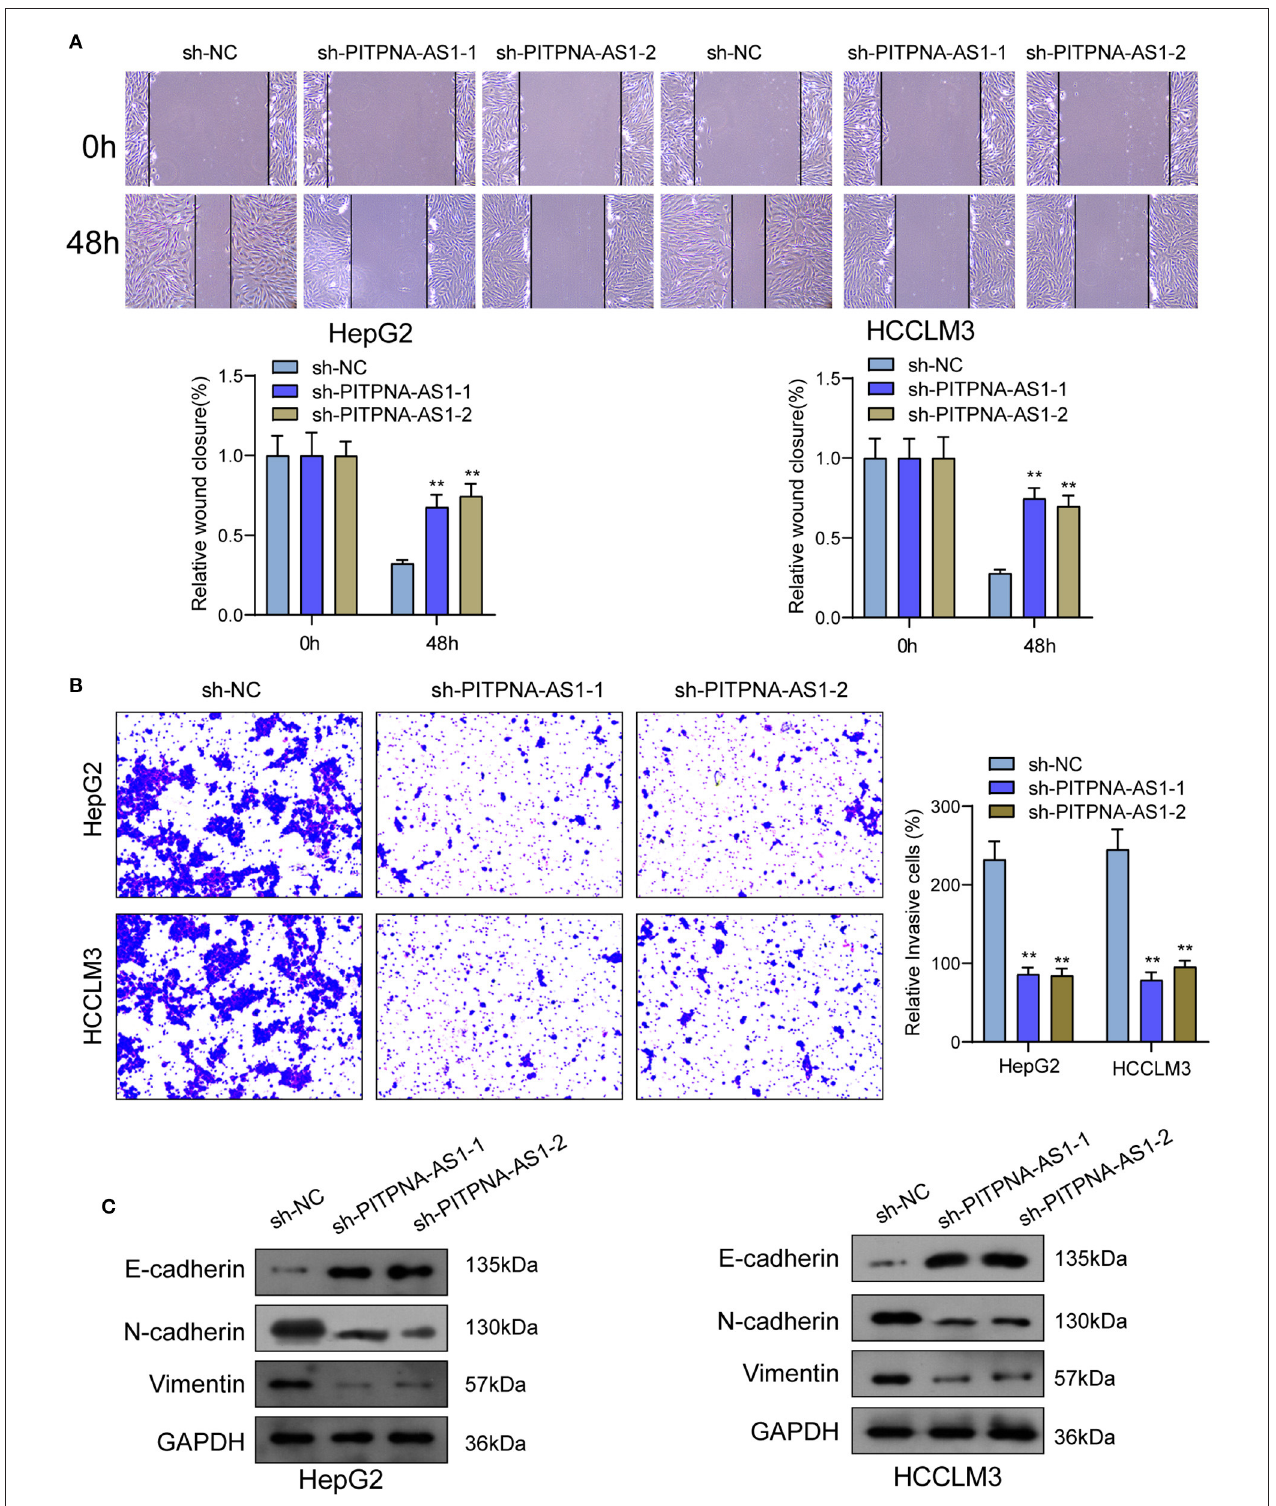
FIGURE 3 | PITPNA-AS1 knockdown inhibited cell migration and invasion of HCC cells. (A) The migration abilities of tumor cells were assessed by wound healing assays. (B) The number of invasion cell was detected by Transwell assays. (C) Western blotting was applied to detect the expression of EMT-related proteins in HepG2 and HCCLM3 cells. ** P <